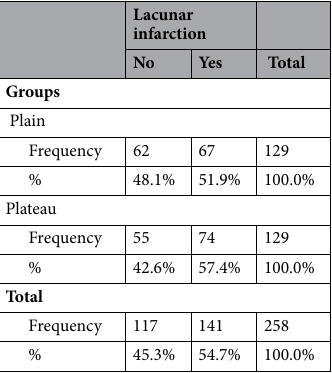
Table 3. The list of lacunar infarction against groups.